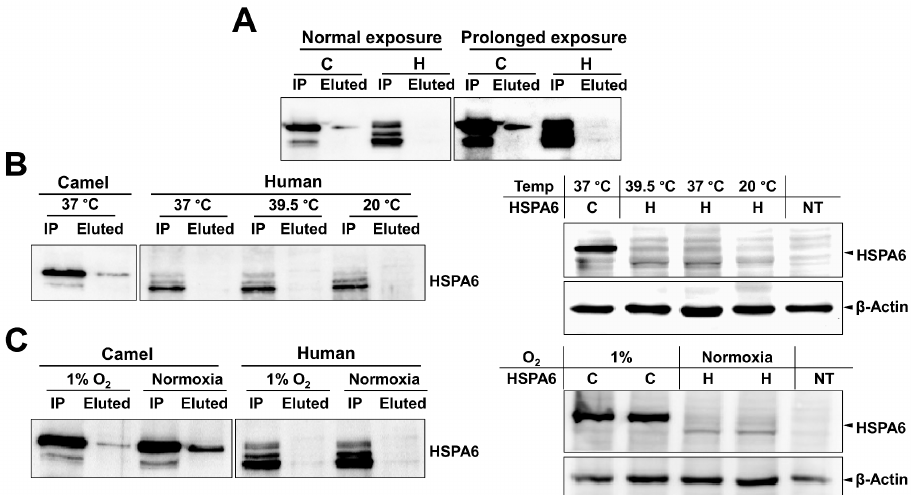
Figure A3. ( A ) cHSPA6 and hHSPA6 transiently expressed in COS-1 cells were subjected to Helix pomatia Sepharose as described previously. The lectin-bound material was immunoprecipitated with anti-Myc and analyzed by Western blotting. hHSPA6 did not bind to the lectin in contrast to cHSPA6 (left panel). The right panel shows an overexposed version of the same blot that also shows that no binding of hHSPA6 to the lectin has occurred; ( B ) The lectin pull down assay was repeated under different temperatures as indicated (left panel). No O -GlcNAc modified forms of hHSPA6 were detected in contrast to cHSPA6 that bound to the lectin. The right panel shows Western blot of the corresponding total lysates as control; ( C ) Similar to ( B ), the same lectin experiment was performed after different oxygen treatments. Here again no O -GlcNAc forms of hHSPA6 in contrast to cHSPA6 that revealed O -GlcNAc forms under both hypoxic and normoxic conditions. The Western blot of the corresponding lysates is shown at the right panel as control.